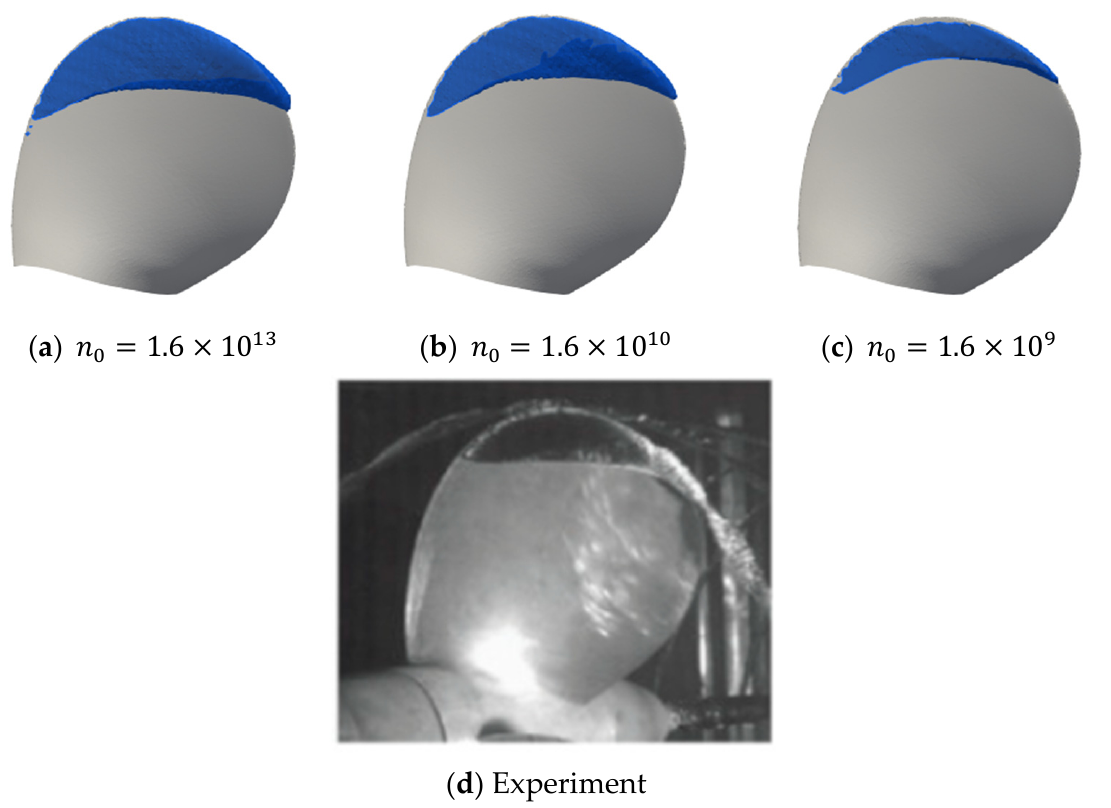
Figure 4. Cavitation on INSEAN E779A propeller blade for various nucleus densities (Salvatore et al., [22]).